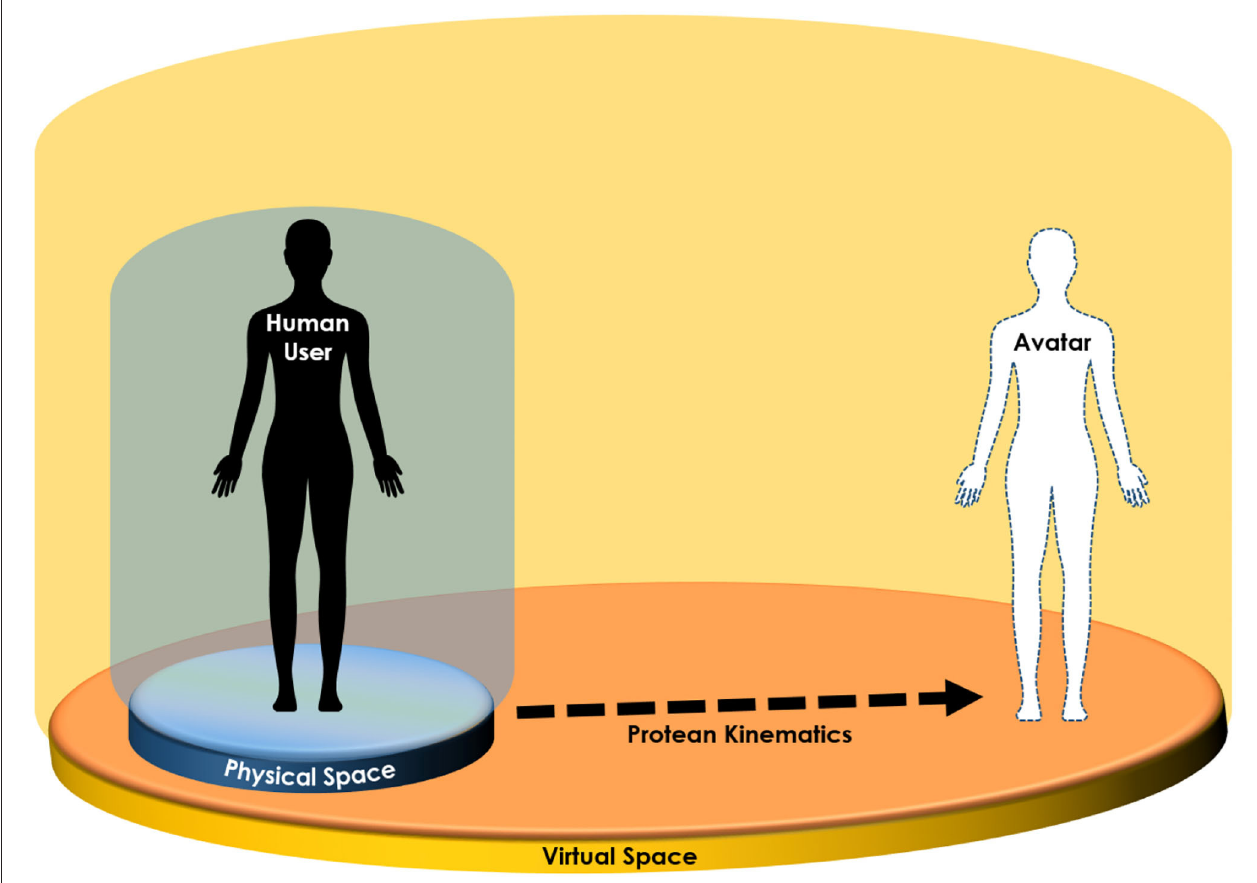
FIGURE 1 | Protean kinematic refers to the idealized virtual movements that can take human users beyond the constraints of their physical affordances (e.g., space).